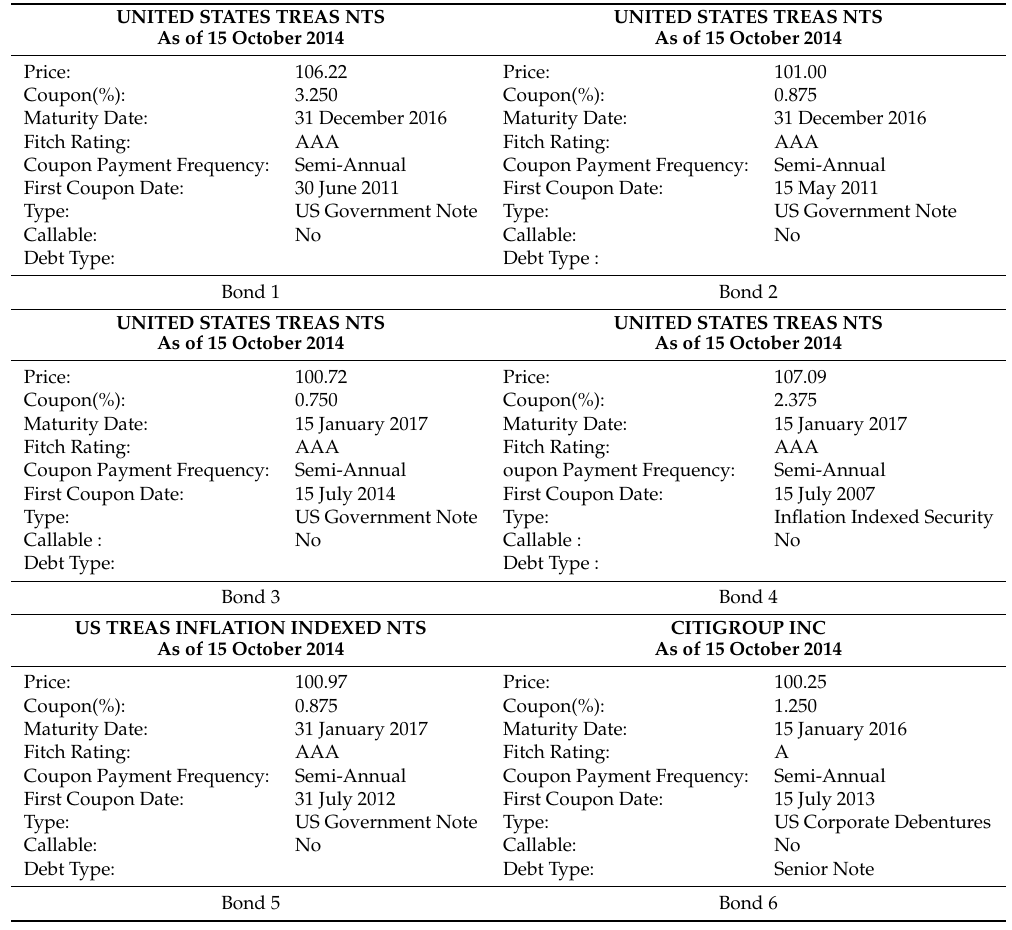
Table 1. Treasury Bonds 1, 2, 3, 4, 5; Corporate Bond